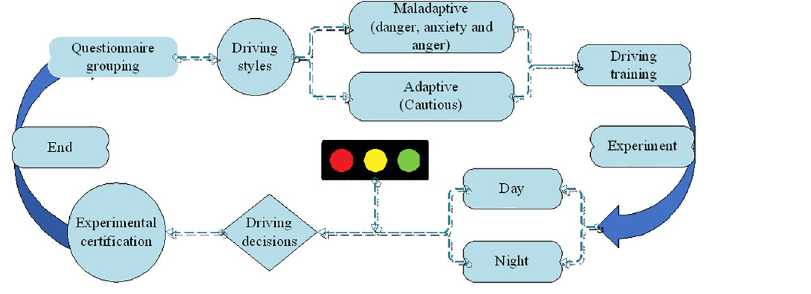
Fig 2. Experimental